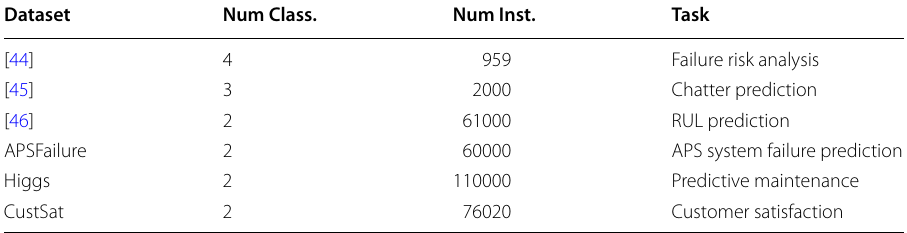
Table 5 List (sample) of datasets used in the evaluation Dataset Num Class. Num Inst.